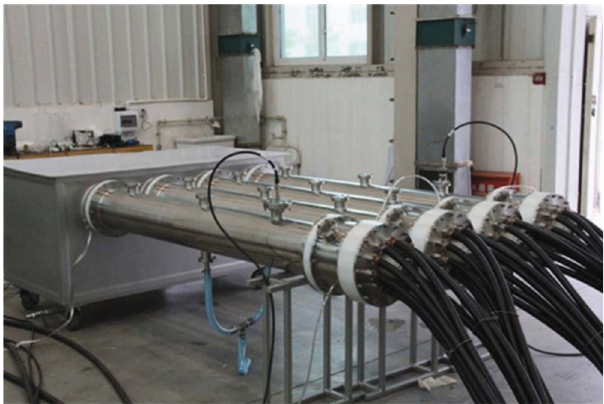
FIG. 18. The first unit of the extendable trigger system. The unit has 40 outputs, and every ten outputs from the same output are controlled by a laser trigger switch.